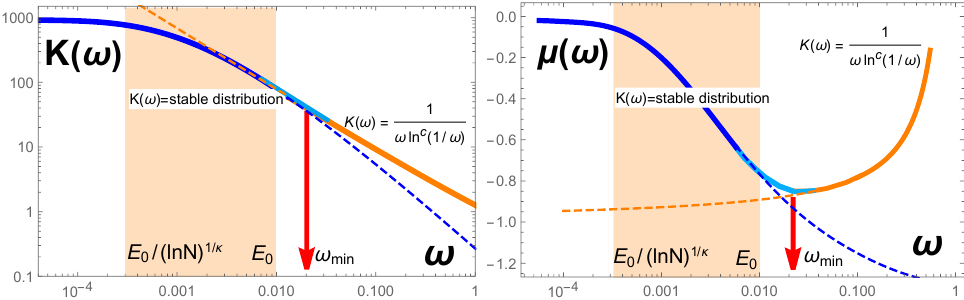
Figure 5: (Color online) The emergent Levy stable distribution. The region of ω (shown by the orange shadow) on the left from the minimum in µ ( ω ) gives the main contribution to the Fourier-transform of K ( ω ) to obtain the stretch-exponential ( t ) at E − 1 (cid:174) t (cid:174) E − 1 ( ln N ) κ . The corresponding parts of the curves behavior of R av 0 0 for K ( ω ) and µ ( ω ) (blue solid lines) are the part of the symmetric about ω = 0 Levy α -stable distribution with α = κ and its log-log derivative, respectively (their continuations are shown by the blue dashed lines) . The parts of the curve K ( ω ) ∼ E and µ ( ω ) on the right of the minimum ω of µ ( ω ) (orange solid lines) are min 0 K ( ω ) ∼ ω − 1 ( ln ( 1 /ω )) − c , which was analytically derived for RRG in Ref. [ 21 ] , and its log-log derivative (their continuations are shown by the orange dashed lines). This (cid:174) t (cid:174) E − 1 part of K ( ω ) is relevant for the Fourier-transforming at shorter times E − 1 BW 0